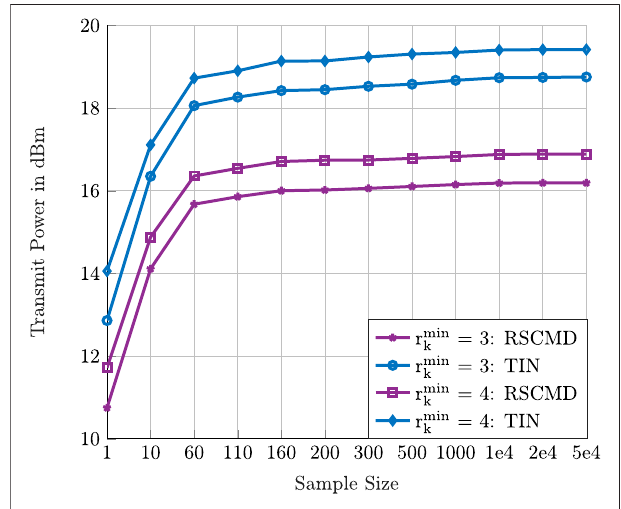
FIGURE 5 | The optimal value of the optimization problem P 2 as a function of the sample